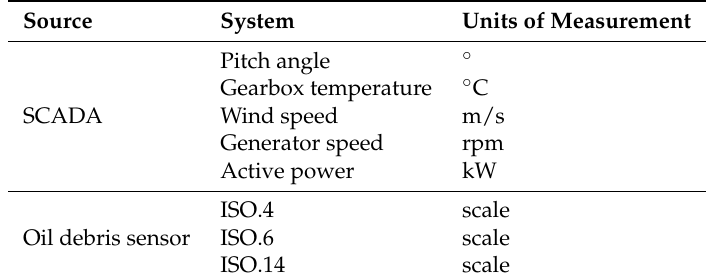
Table 1. Variables available in the dataset and measurement units by data